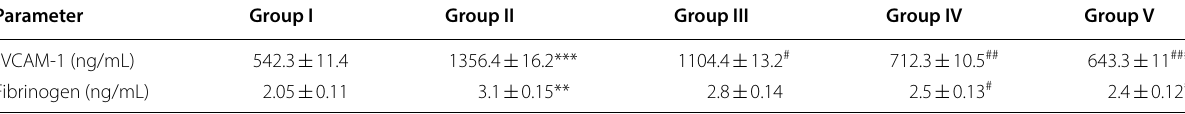
** P < 0.01, *** P < 0.001, # P < 0.05, ## P < 0.01 and ### P <